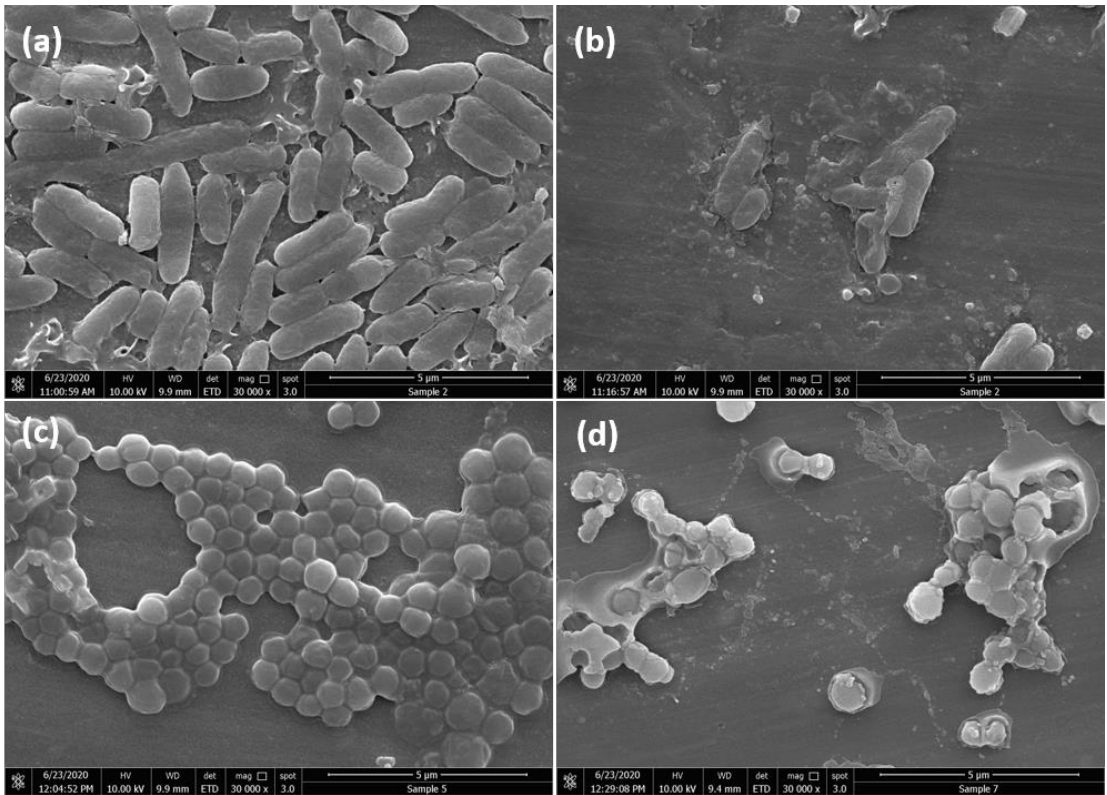
Figure 7. FESEM images of E. coli and S. aureus without any treatment, showing intact cell membrane ( a , c ), and the cells treated with ZnO/TiO 2 /AgNCs after 2 h, showing damaged cell membrane and leakage of the cellular contents ( b , d ).